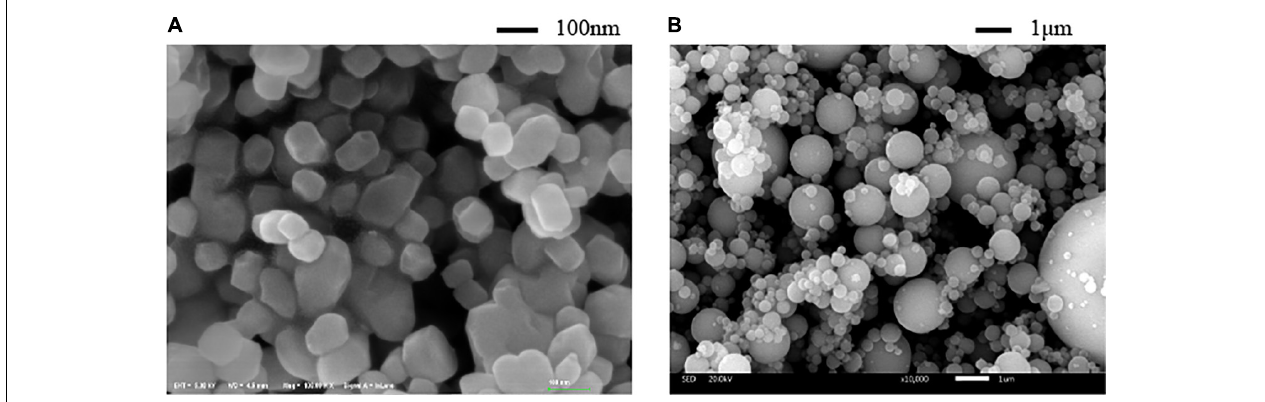
FIGURE 1 | Morphology of nano-CaCO 3 (NC) and fly ash (FA): (A) NC, (B) FA.